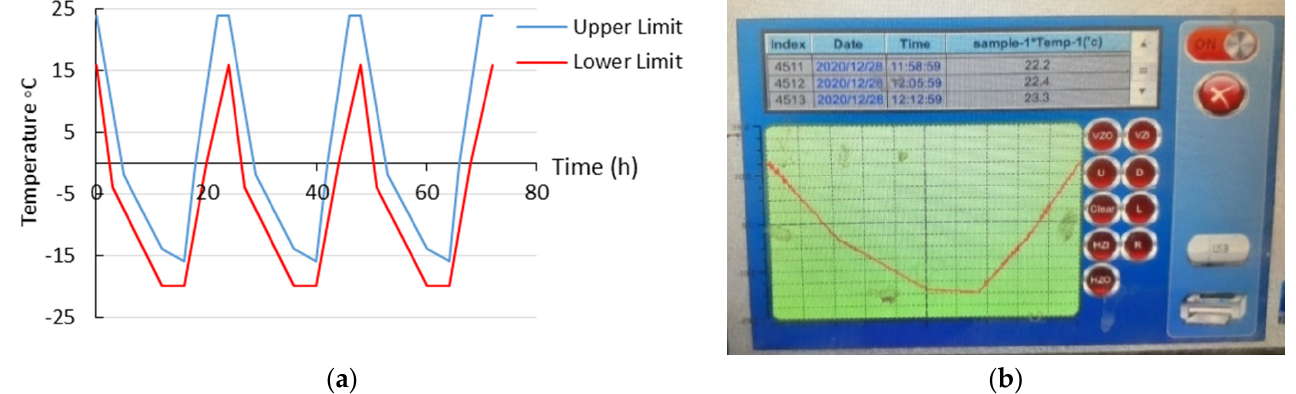
Figure 3. ( a ) Upper and lower limits of cycles of freezing and thawing and ( b ) applied cycles in experimental study.